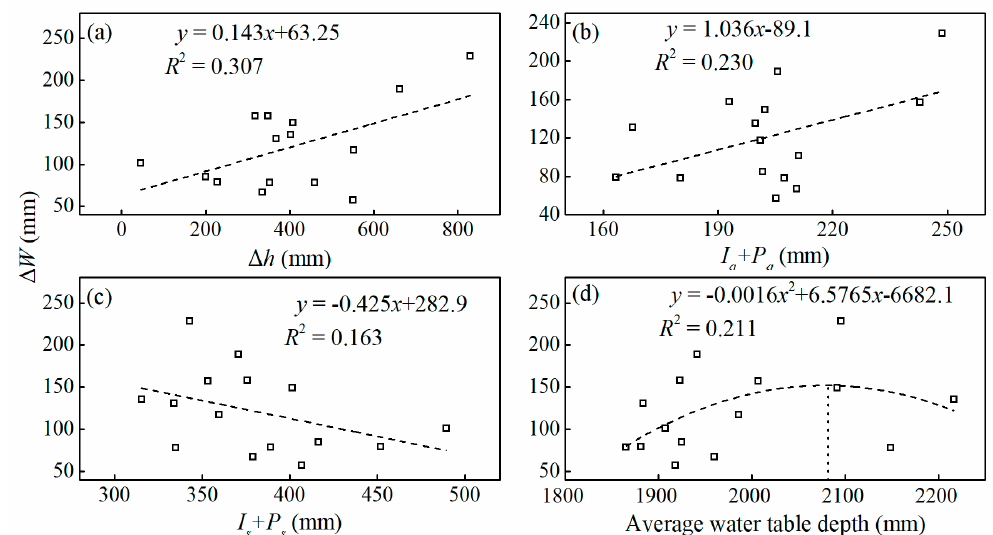
Figure 6. The relationships of ( a ) the increase of the water table depth during the crop growing season ( ∆ h ), ( b ) the total water supply during the non-growing season ( I a + P a ), ( c ) the total water supply during the crop growing season ( I s + P s ), and ( d ) the average water table depth during the crop growing season h with the soil-ground water storage utilization ( ∆ W